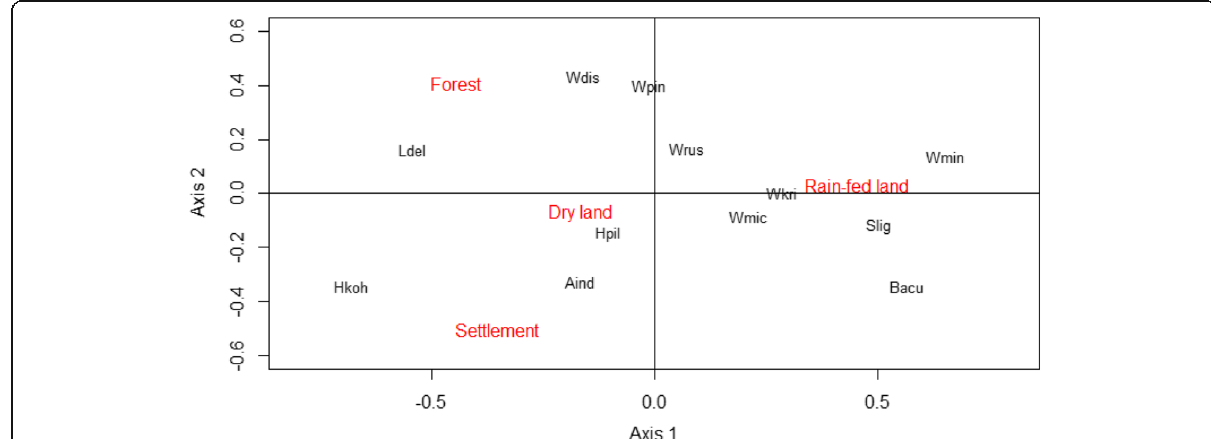
Fig. 2 Correspondence analysis showing the association between the 12 dominant chigger species (Aind, Ascoschoengastia indica ; Bacu, Blankaartia acuscutellaris ; Hkoh, Helenicula kohlsi ; Hpil, Helenicula pilosa ; Ldel, Leptotrombidium deliense ; Slig, Schoengastiella ligula ; Wdis, Walchia dismina ; Wkri, Walchia kritochaeta ; Wmic, Walchia micropelta ; Wmin, Walchia minuscuta ; Wpin, Walchia pingue ; Wrus, Walchia rustica ) within the four categorized habitats. The first and second dimensions explain 87% of the total variance (axis 1, 59.82%; axis 2,